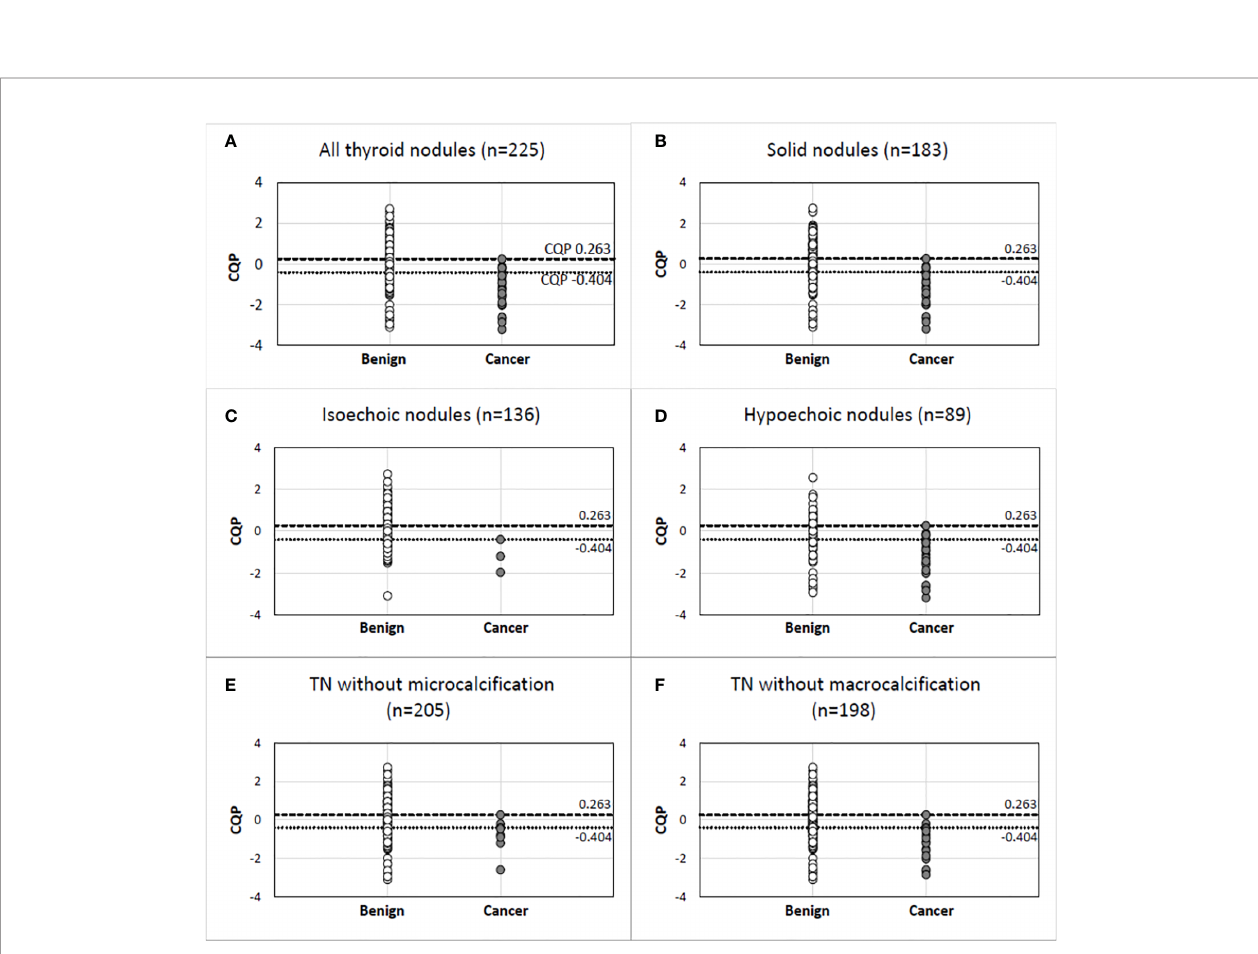
FIGURE 2 | Combination QUS parameter (CQP) distribution in malignant and benign pathology in all thyroid nodules (A) and in nodules selected based on speci fi c gray-scale ultrasound features (B – F) . Benign nodule (open circle). Cancer (closed